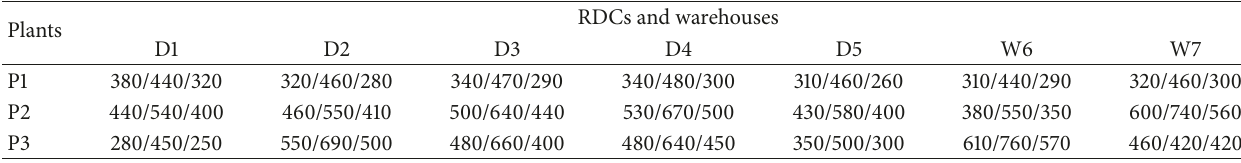
Table 5: Distance from plants to potential RDCs by different transport modes